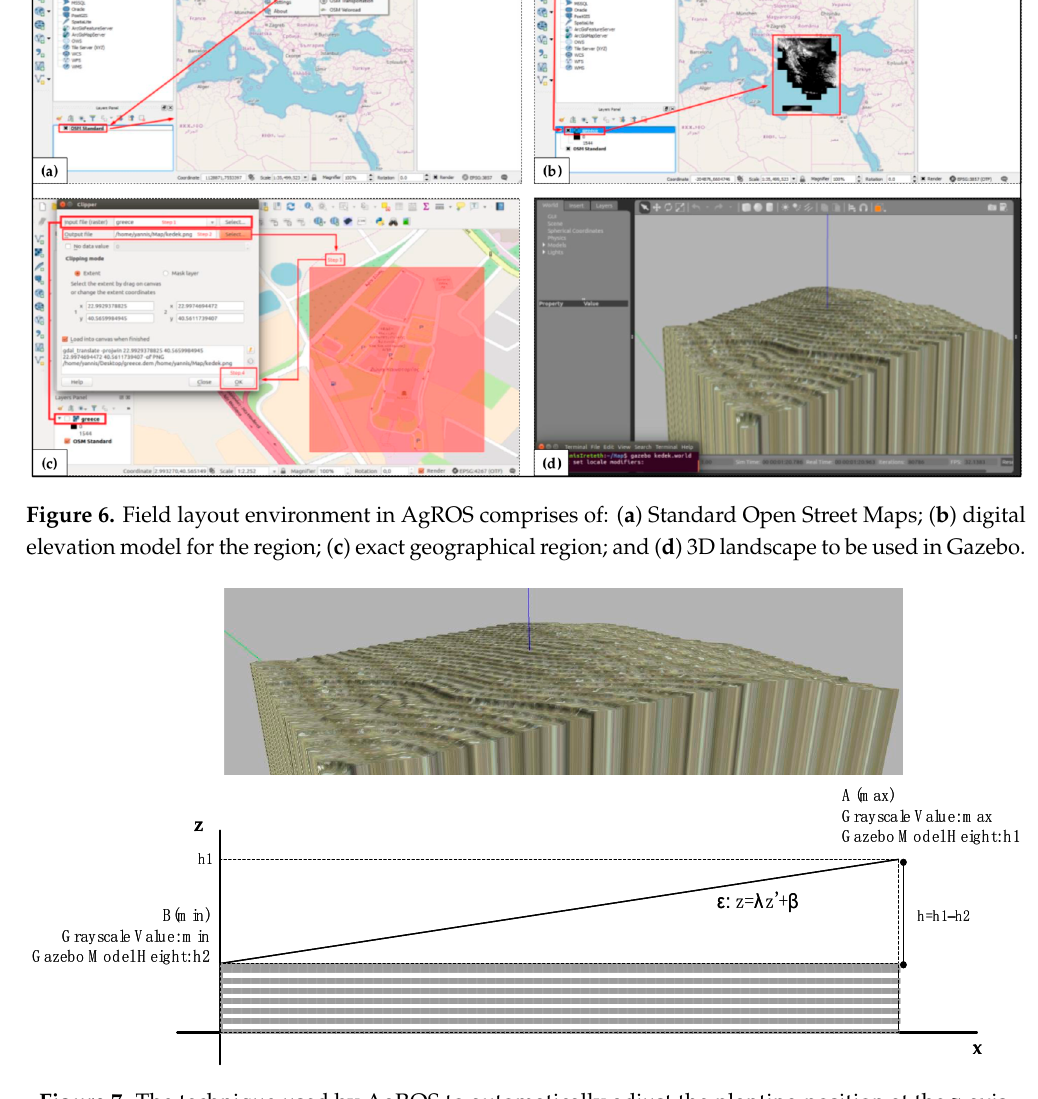
Figure 7. The technique used by AgROS to automatically adjust the planting position at the z -axis.